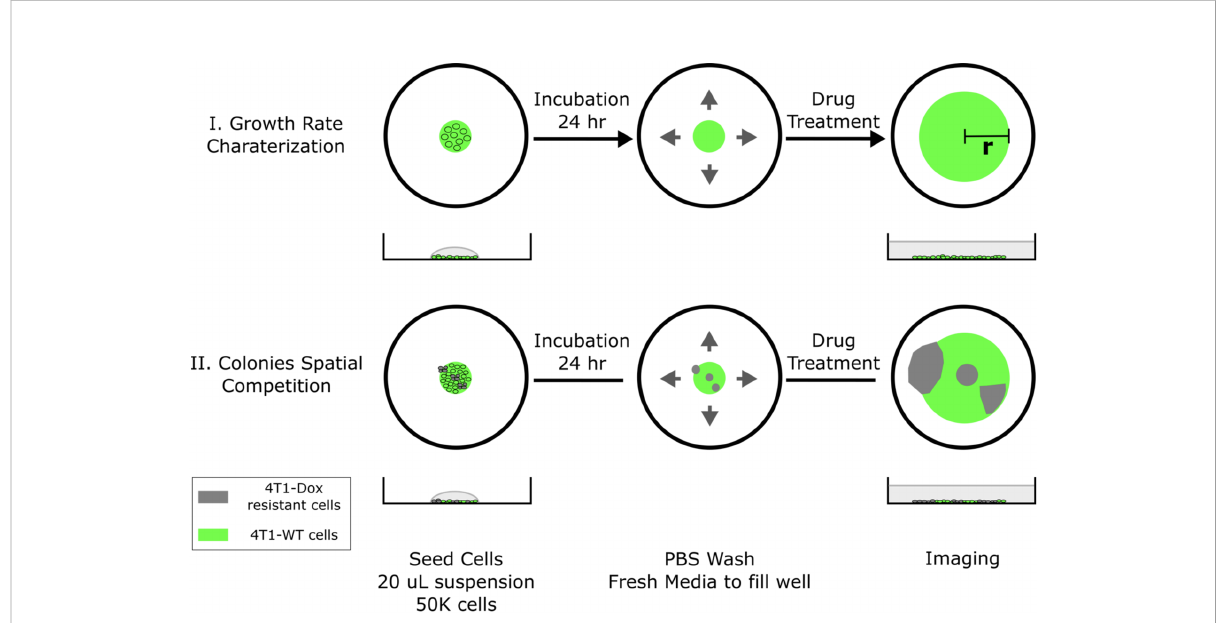
FIGURE 1 Schematic of 2D spatial colony system. (top, case I) Chemosensitive 4T1 cells are seeded in a well plate and grow radially, where colony radius and cell fl uorescence are tracked over time. (bottom, case II) A mixture of chemosensitive and chemoresistant cells are premixed or spotted sequentially to establish a spatial competition model between cell